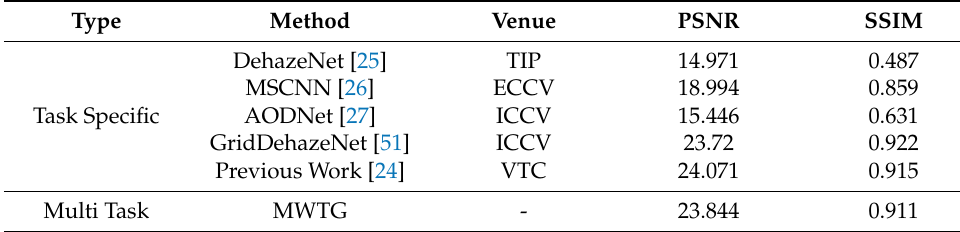
Table 1. Comparison of results with Foggy Cityscapes.